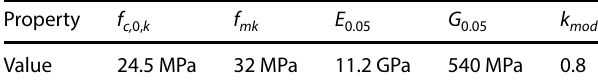
Table 1 Material properties of glulam timber with strength class GL32c Property